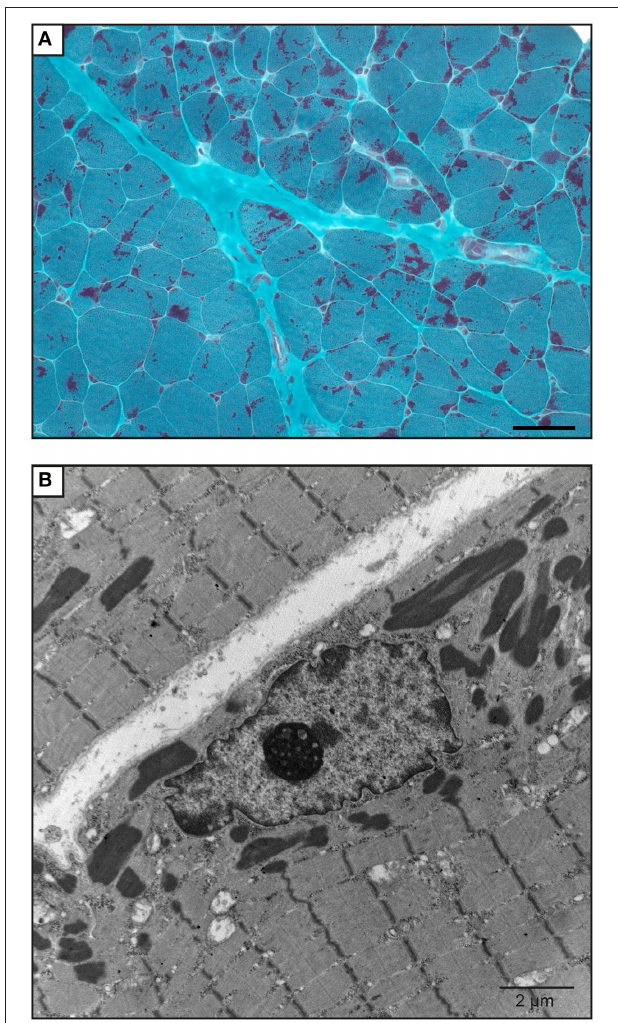
FIGURE 3 | Muscle biopsy of the patient. (A) Gömöri trichrome staining of a quadricep muscle biopsy section shows mild anisomorphism fibers. More than 90% of the fibers have red stain inclusions typical of nemaline rods. Scale bar = 50 µ m. (B) Electron microscopy image shows cytoplasmic rod-shaped nemaline bodies. No intranuclear rods were observed. Magnification, × 3,200; scale bar = 2 µ